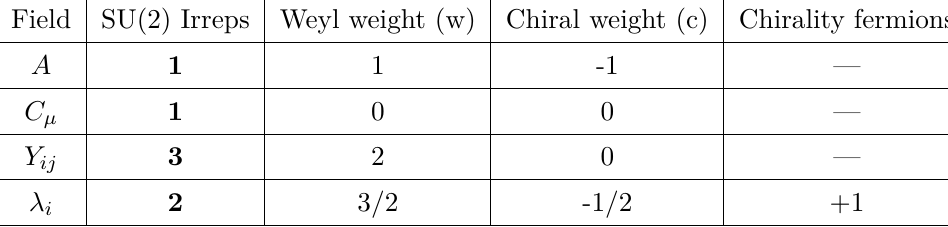
Table 4 . N = 2 superconformal vector